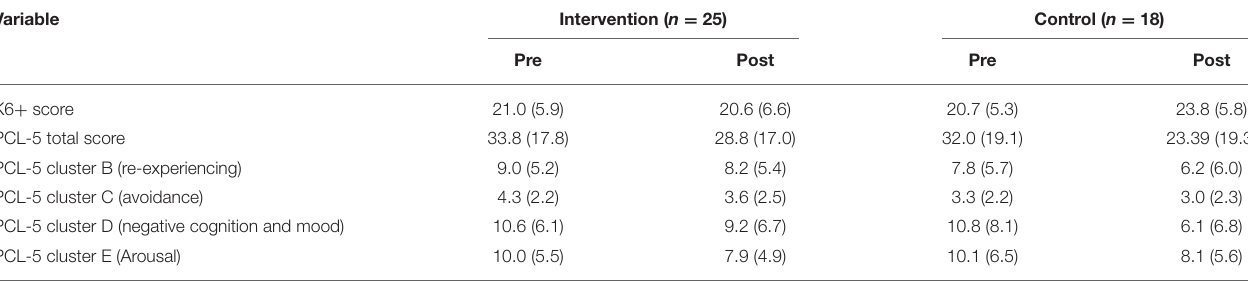
TABLE 5 | Mental health symptoms before and after a dance/movement workshop intervention.